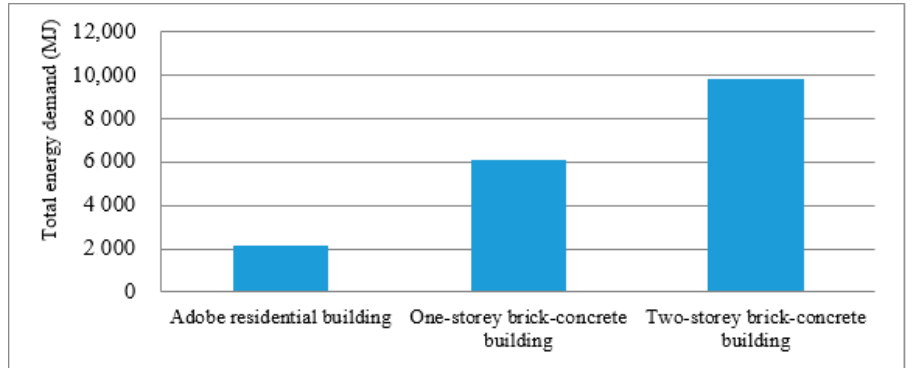
Figure 13. Energy demand of unit construction area in the process of building demolition.